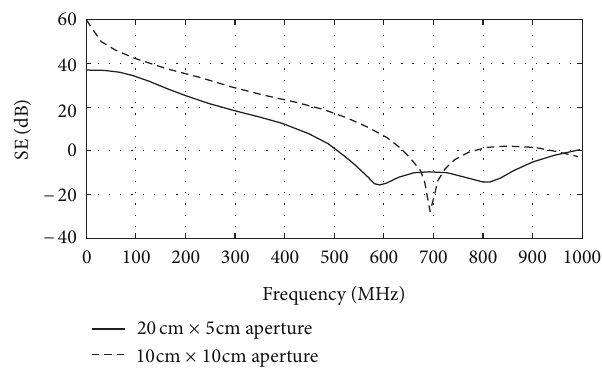
F 11: Shielding effectiveness versus frequency for a box- shaped enclosure of dimensions 30 as that with two slots.